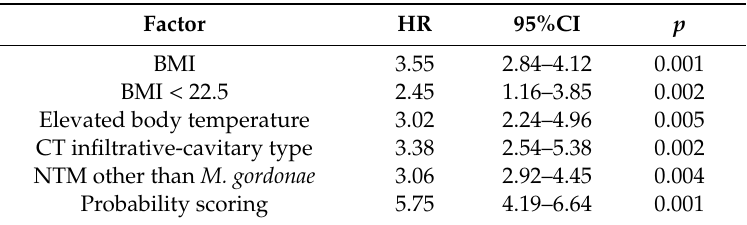
Table 4. Risk of NTM-LD in 36 patients with obstructive lung diseases based on clinical, microbiological and radiological